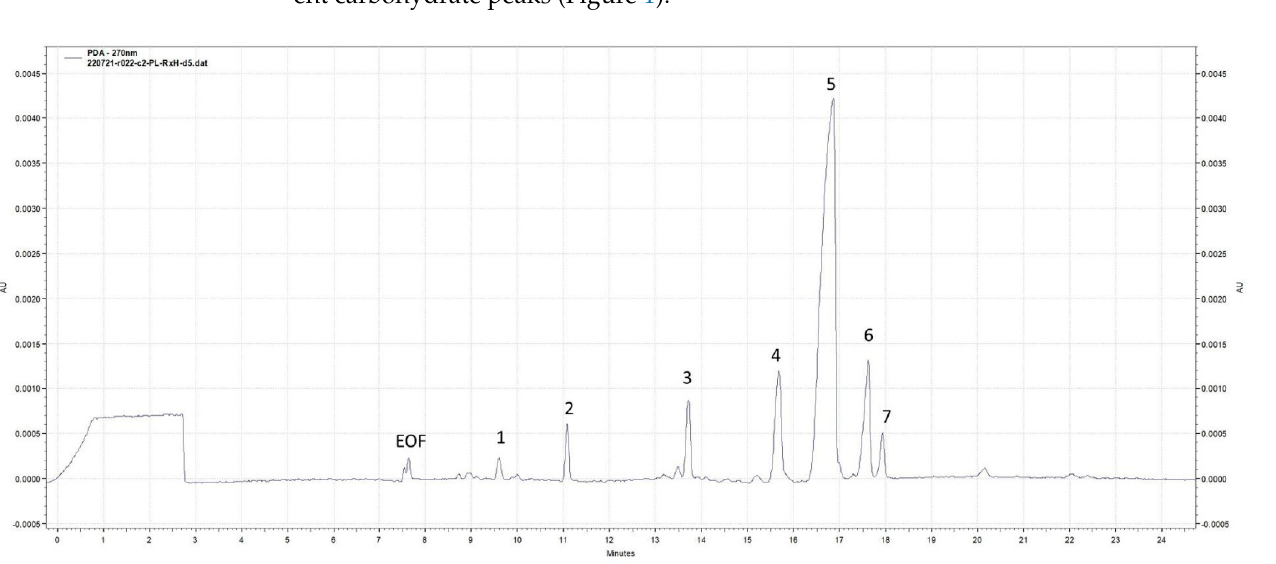
Figure 1. Electropherogram of components of crude polysaccharide from R. rugosa root (CPL-Rx).